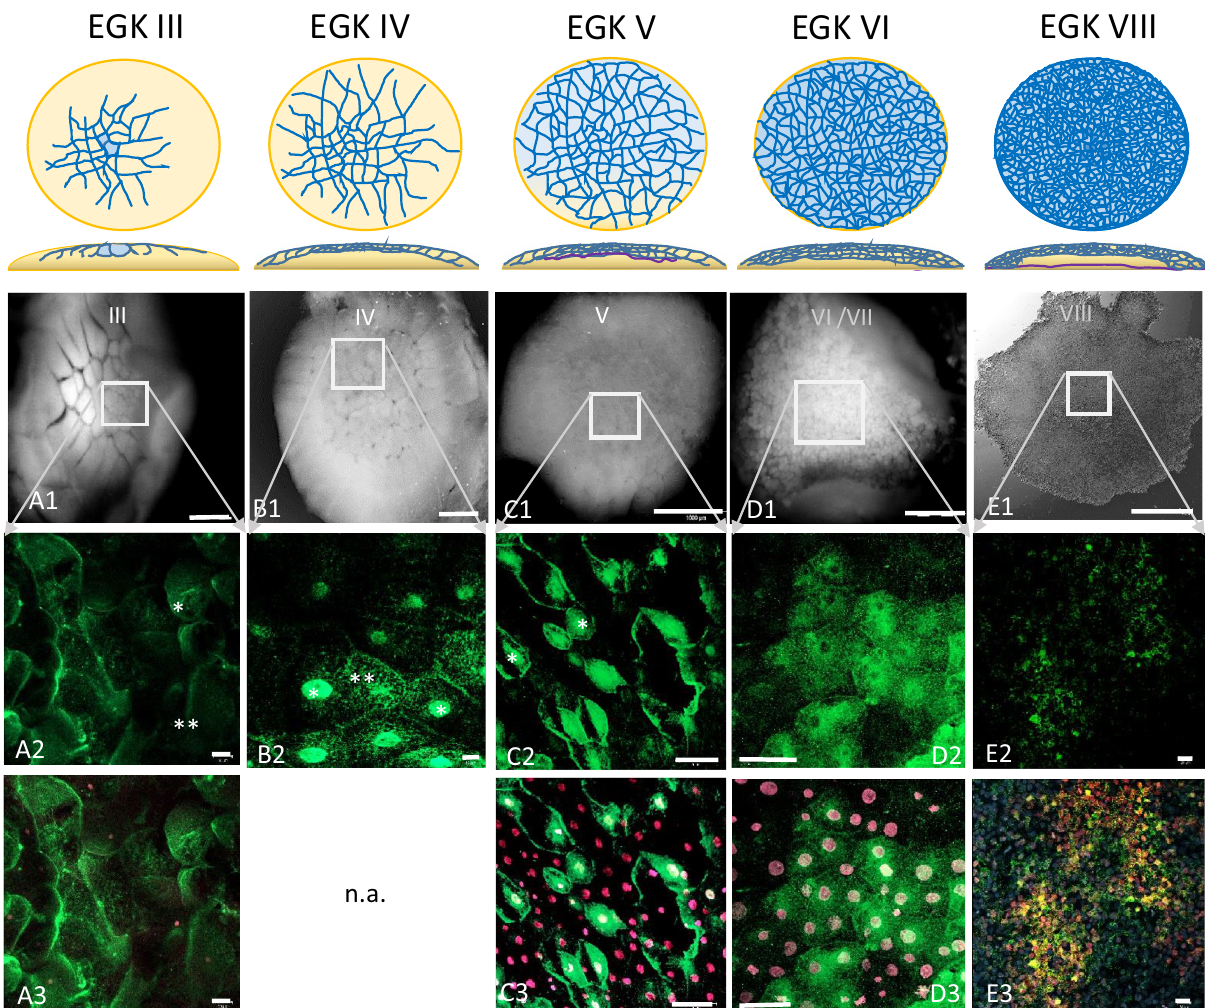
Figure 5. Dynamic localization of Bucky ball around major zygotic genome activation. The upper panel represents schemes for the formation of cells from stage EGK III, where first centrally located cells get separated to stage VIII, the second stage of area pellucida formation phase as described by Eyal-Giladi and Kochav 28,29 ( A1 ) An eccentrical position (rectangular frame in ( A1 ), upper left panel) of the cleavage center within the chicken germinal disc region. With the ongoing cell divisions during EGK III, Bucky ball protein granules start to accumulate in the cytoplasm of the medial cleavage center in first laterally and ventrally closed cells (* in A2 ). The protein is not found accumulating around or in the nuclei stained with SIR and visualized in red. In the more lateral cells, the protein is still located in or around the cleavage furrows (**). At seven to eight hours after fertilization (hpf) during stage EGK IV, Bucky ball is first observed in the nuclei of central cells with very high intensity of labeling ( B2 *), whereas at the surrounding cells Bucky ball is still located in the cytoplasm ( B2 **). The same pattern of intracellular protein localization of Bucky ball was recorded in stage V embryos ( C1 overview, C2 magnified central frame with nuclear and cytoplasmic labeling of Bucky ball. ( A3 , C3–E3 ) demonstrate SIR counterstained nuclei and the concentration of Bucky ball in and around them. After around 12 hpf, when embryos developed to stage VI, Bucky ball seems to decrease in intensity overall and the nuclear signals disappear ( D2 ). This process of signal reduction proceeds further to stage VIII and no nuclear labeling remained ( E2 ). The basal membrane is separating the yolk from the developing embryo, and starts growing from the middle to the edges of the disc at stage V, (purple line, scheme above column C ) and reaches the outline of the disc at stage VI (scheme, column D ). The subgerminal cavity is formed between the embryo and the basal membrane via cell shedding to the outline forming the area pellucida from stage VII onwards (scheme, column ( E )). Scales ( A1–E1 ) = 1 mm, ( A2,A3,C2,C3 ) = 50 µm; ( B2,D2,D3 ) = 10 µm, ( E2,E3 ) = 20